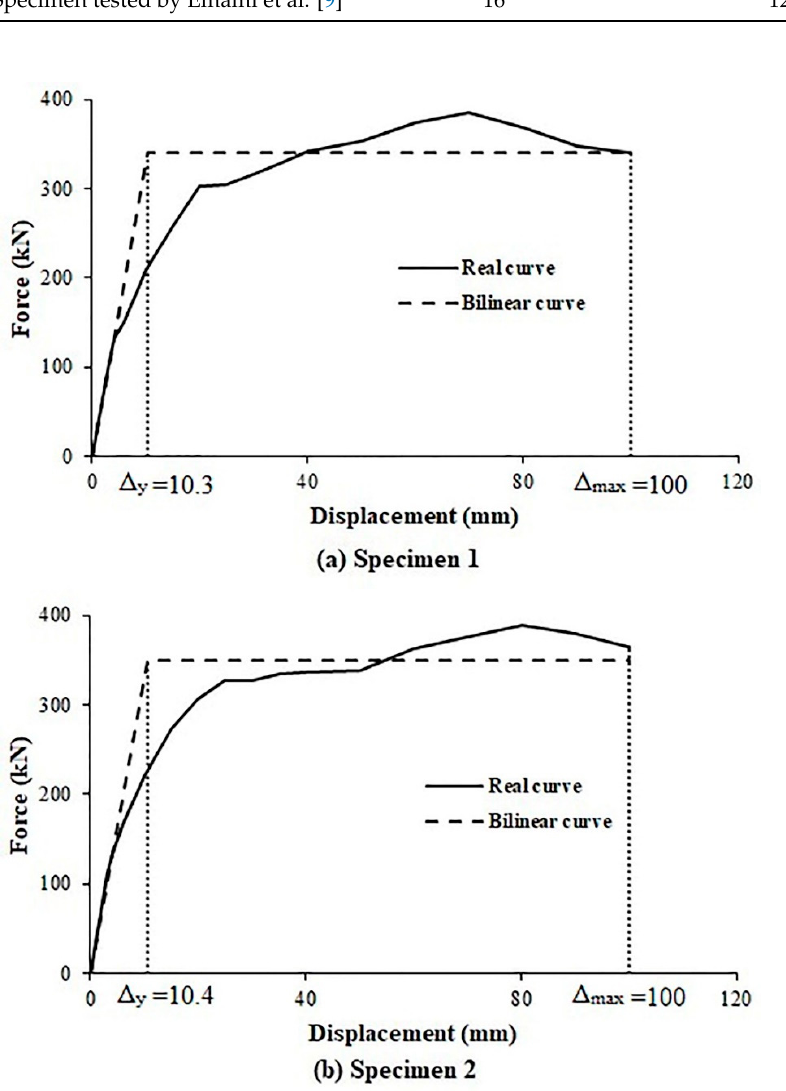
Figure 16. Real and bilinear force-displacement curves.